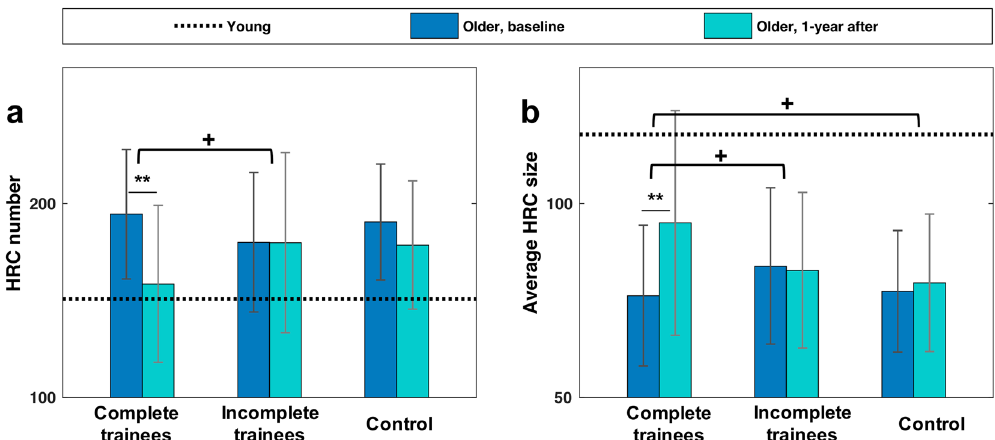
Figure 4. Training effect on HRC. ( a ) HRC number of the complete trainees, incomplete trainees, and control participants. ( b ) Mean HRC size of the complete trainees, incomplete trainees, and control participants. The error bars indicate standard deviation. Dashed lines indicate the average values of these two measurements in younger participants. Solid lines indicate within-group comparison, while horizontal square brackets indicate between-group comparison ( ** p < 0.01, + p < 0.1). HRCs in this figure were defined as the 10% highest ReHo values, and were constrained by grey matter shape. No between-group difference in HRC number or mean HRC size was found at baseline. Potential confounding factors (gender, education, FD) were